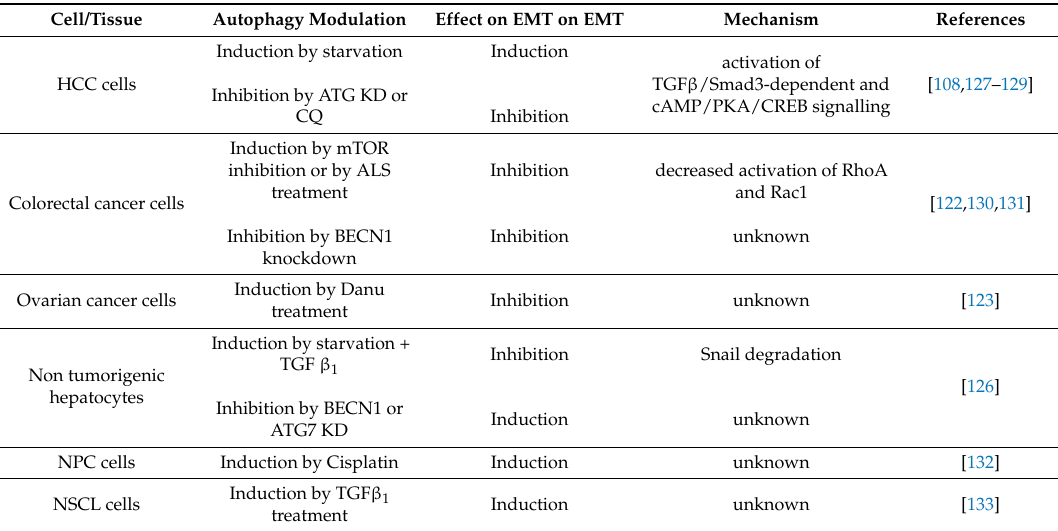
Table 1. Autophagy and